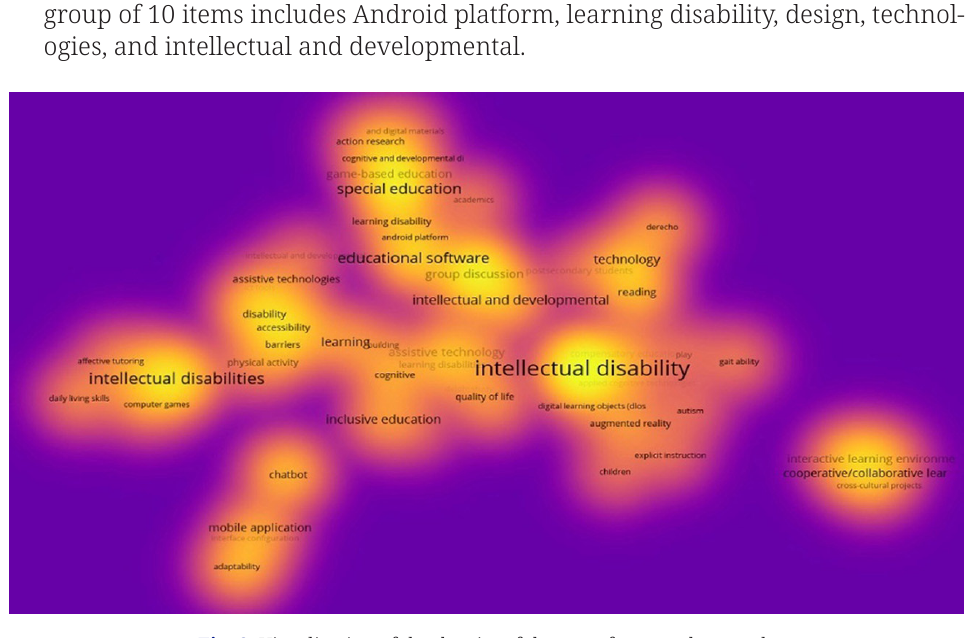
Fig. 8. Visualization of the density of the most frequent